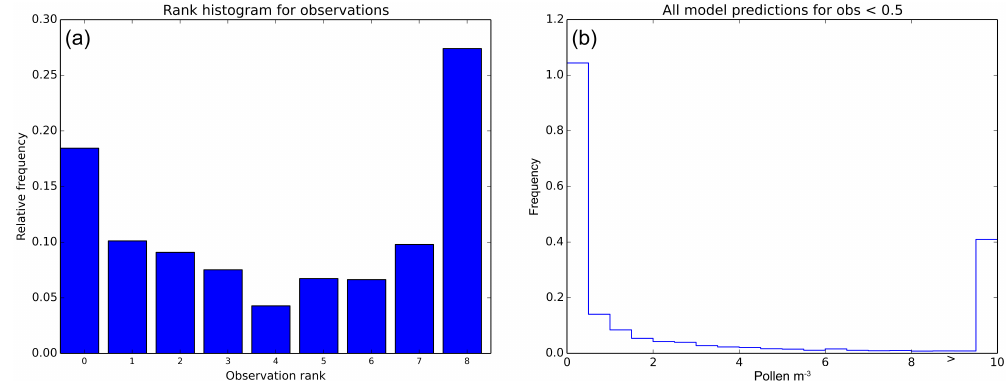
Figure 9. Ensemble characteristics. (a) Discrete rank histogram for the constructed ensemble (daily concentration statistics); (b) histogram of model predictions when observations were below the detection limit of 0.5pollenm − 3